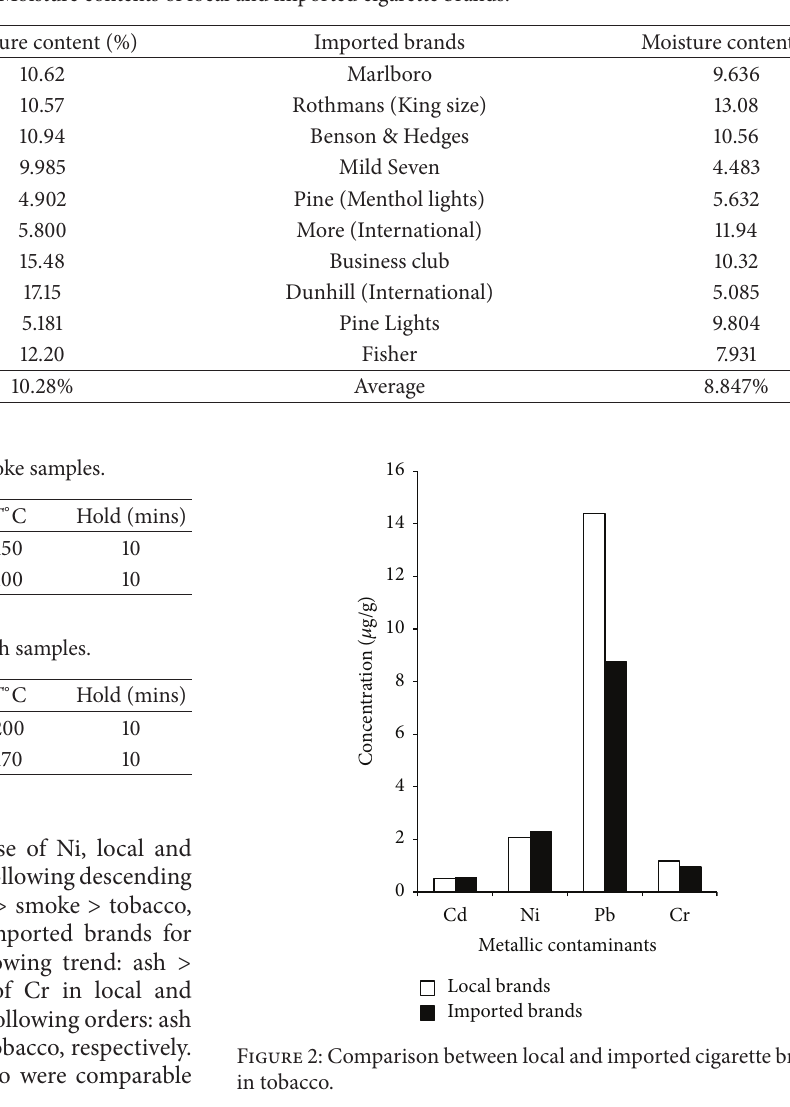
Table 1: Moisture contents of local and imported cigarette brands.